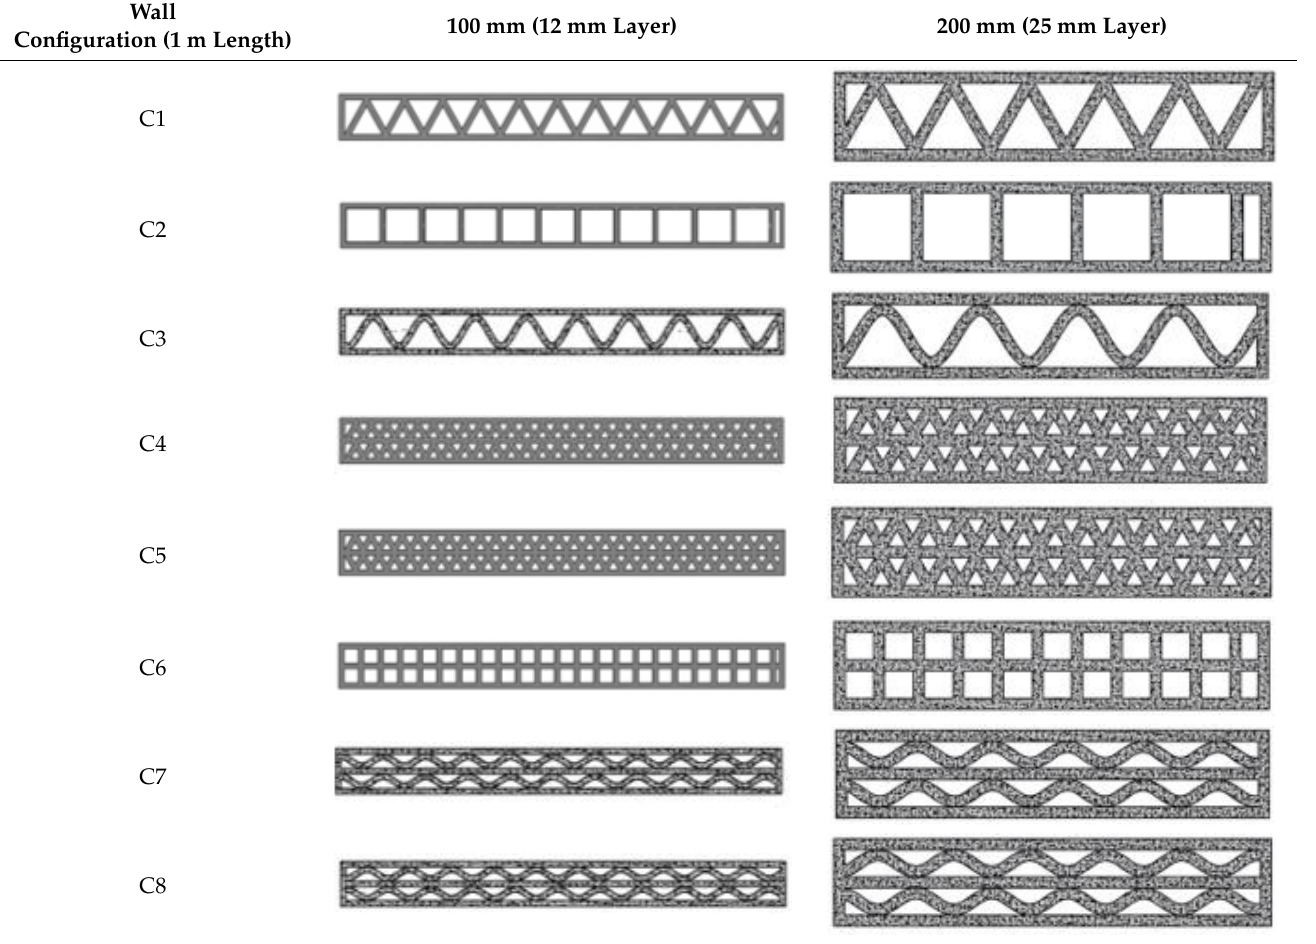
Table 5. The U -values derived from the FE analysis.